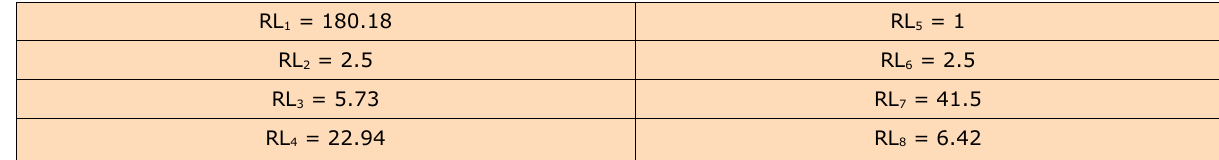
Table 13. FRA risk score of hazard